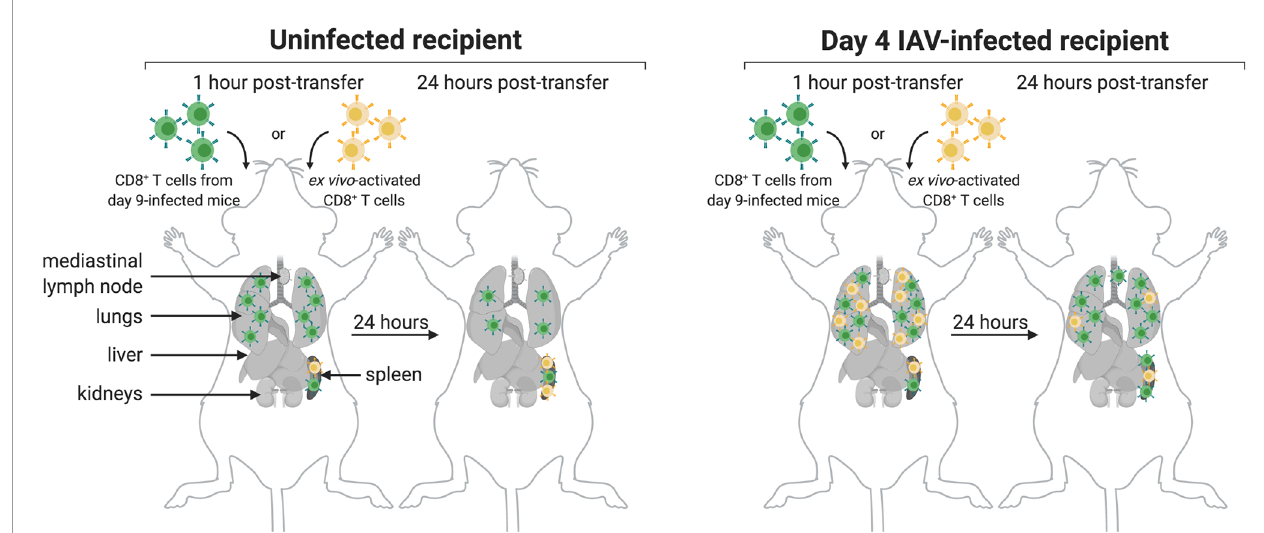
FIGURE 6 | Model of CD8 + T Cell Transfer to Infected and Uninfected Mice. CD8 + T cells transferred from day 9-infected mice (green) initially localize to the lungs and spleen of uninfected (left) and IAV-infected (right) mice. After 24 hours, these cells are retained in the lungs and spleen of both uninfected and infected mice, though retention is not as strong in the lungs of uninfected mice. Additionally, a subset of these cells migrates to the MLN of infected mice after 24 hours. Transferred ex vivo activated CD8 + T cells (yellow) initially localize to the spleen of both uninfected and infected mice, and in both cases remain there after 24 hours. While these cells do not localize to the lungs of uninfected mice, they do transiently populate the lungs of infected mice; however, these cells are not retained in the lungs after 24